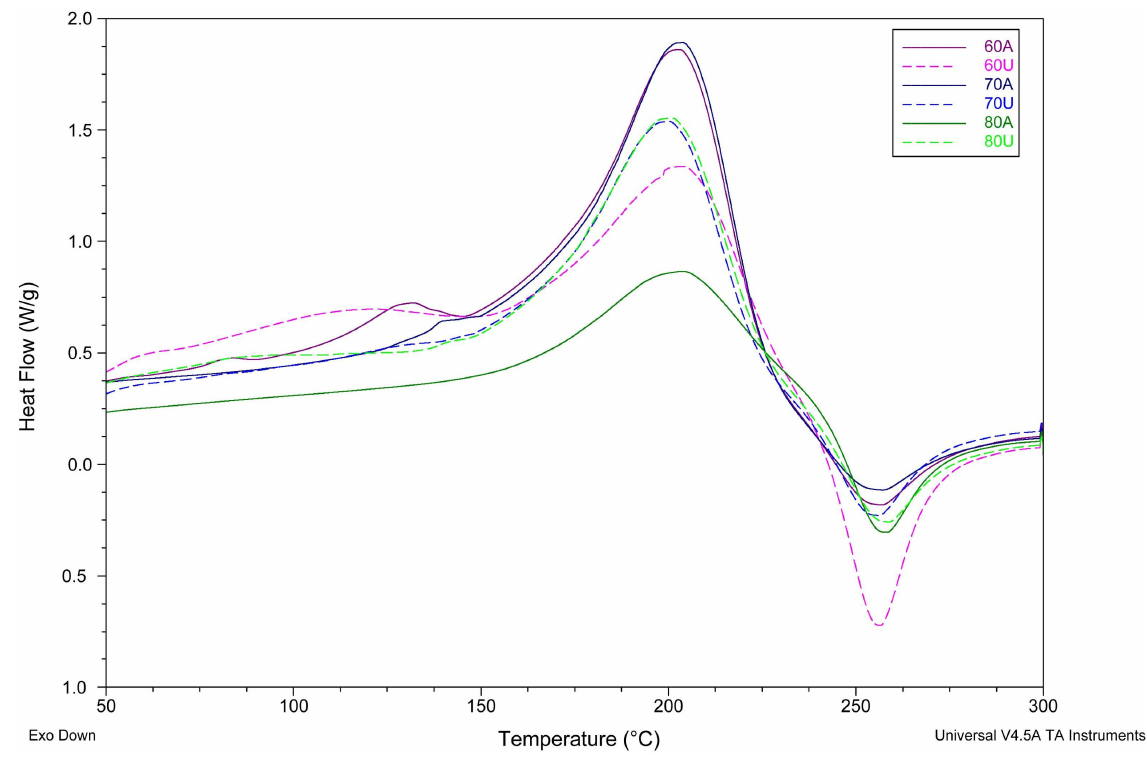
Figure 4. DSC thermograms in the full temperature range of citrus pectins extracted at 60 °C, 70 °C, and 80 °C by (A) citric acid in pH 1.5 and (U) citric acid in pH 1.5 with the addition of ultrasounds, precipitated using